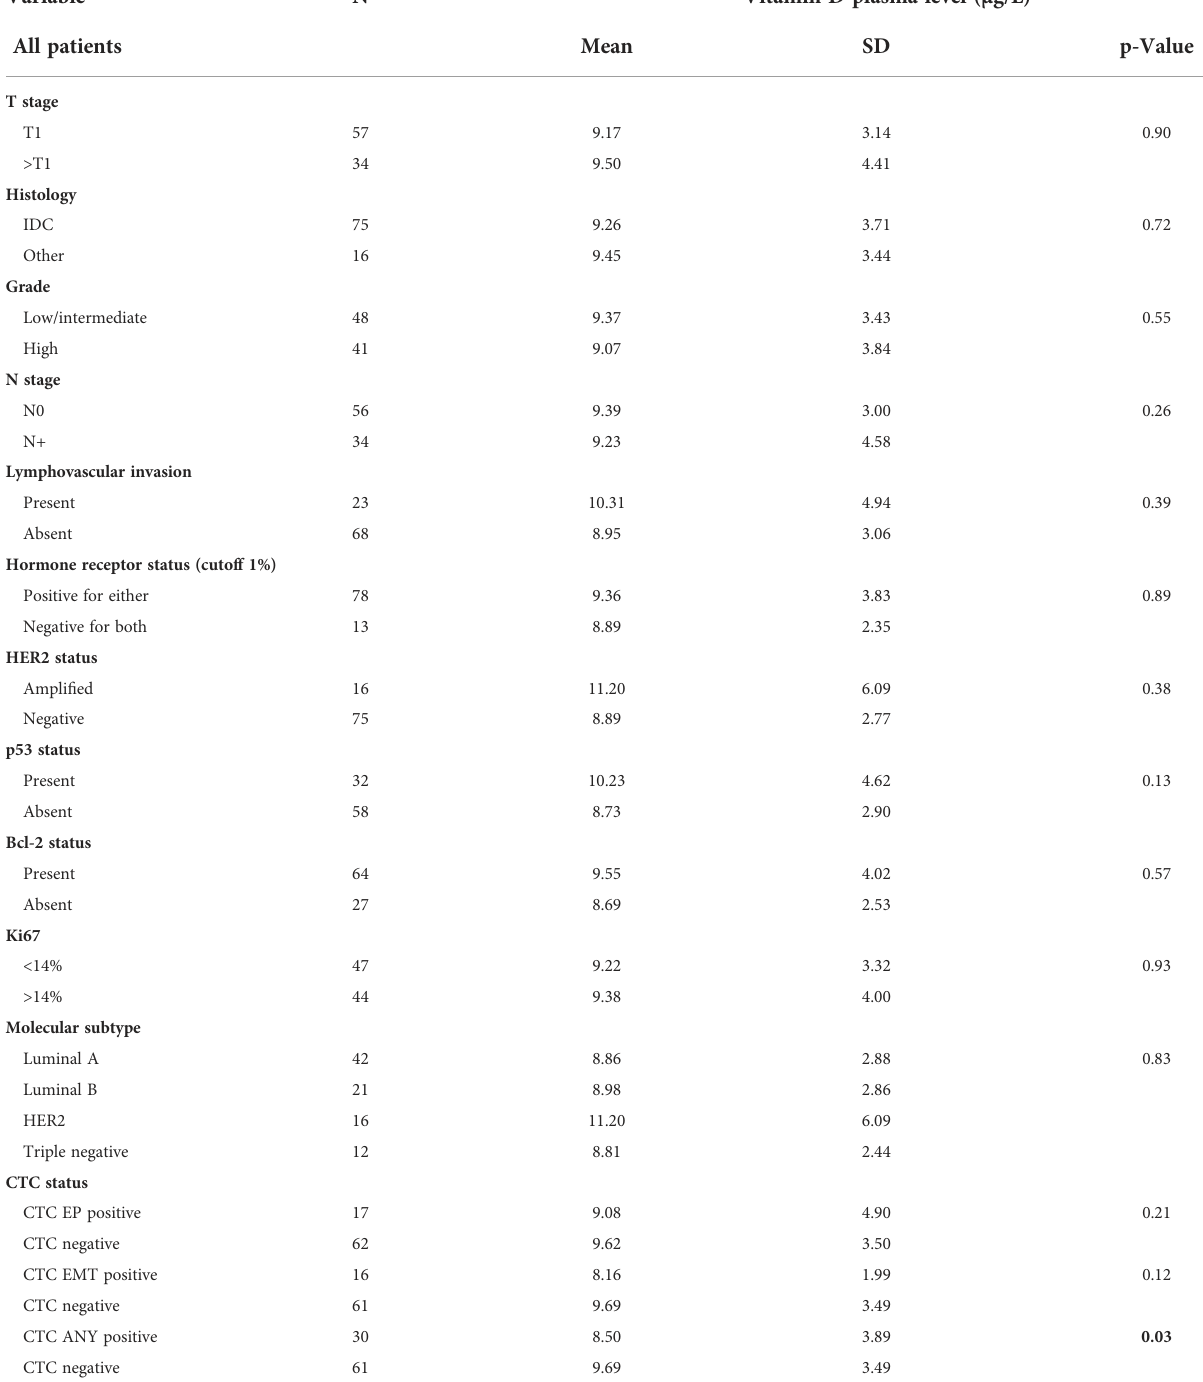
TABLE 2 Association between plasma vitamin D level and patient/tumor